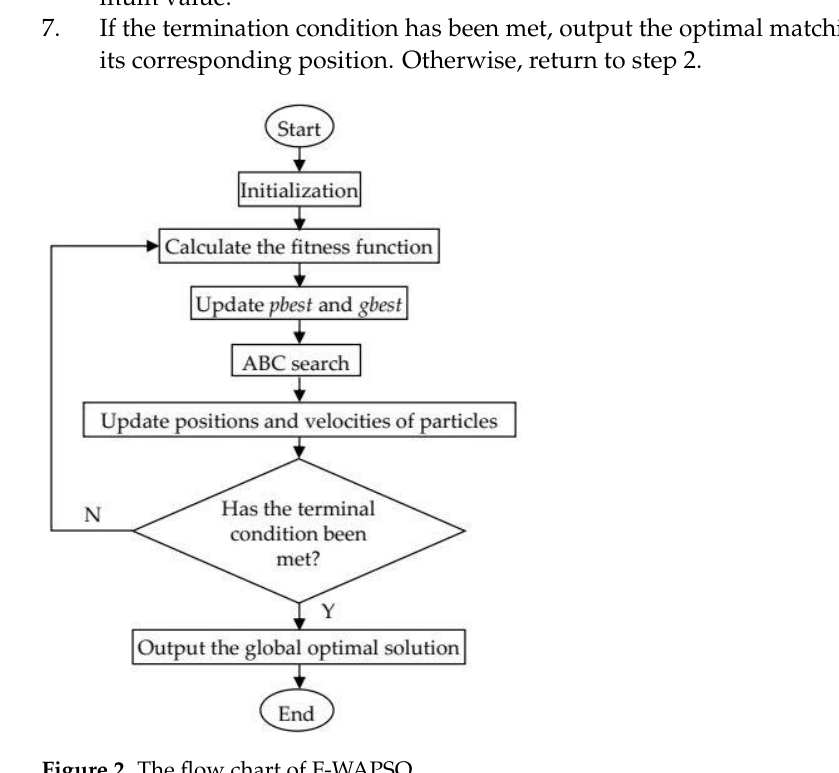
Figure 2. The flow chart of F-WAPSO.